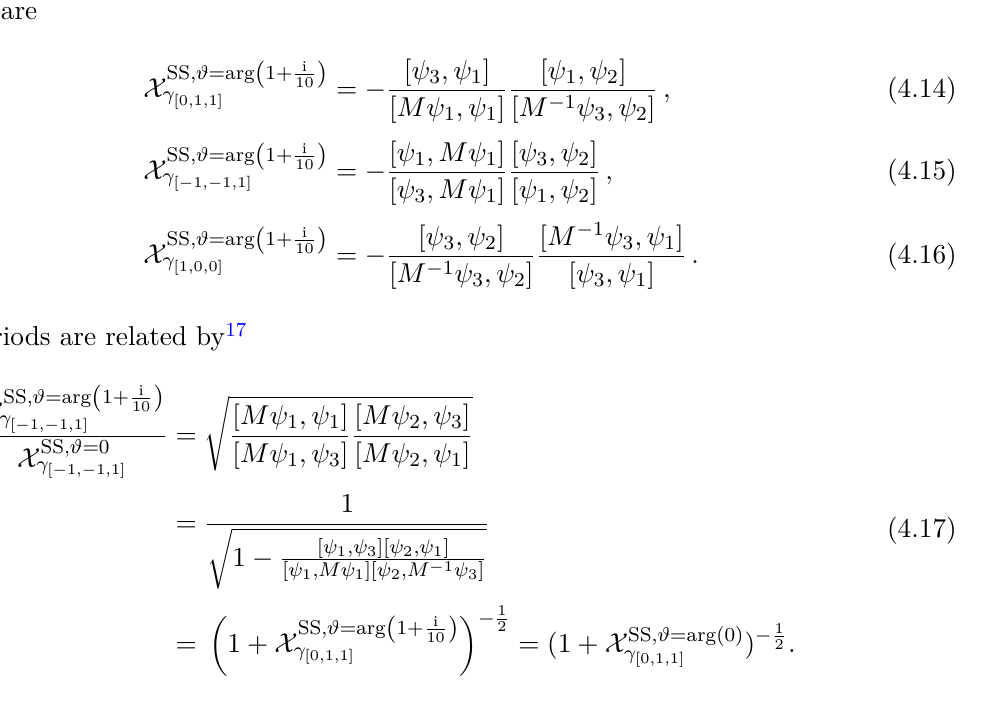
Figure 9 . Spectral network and local bases of solutions corresponding to ϑ = arg other parameters as in figure